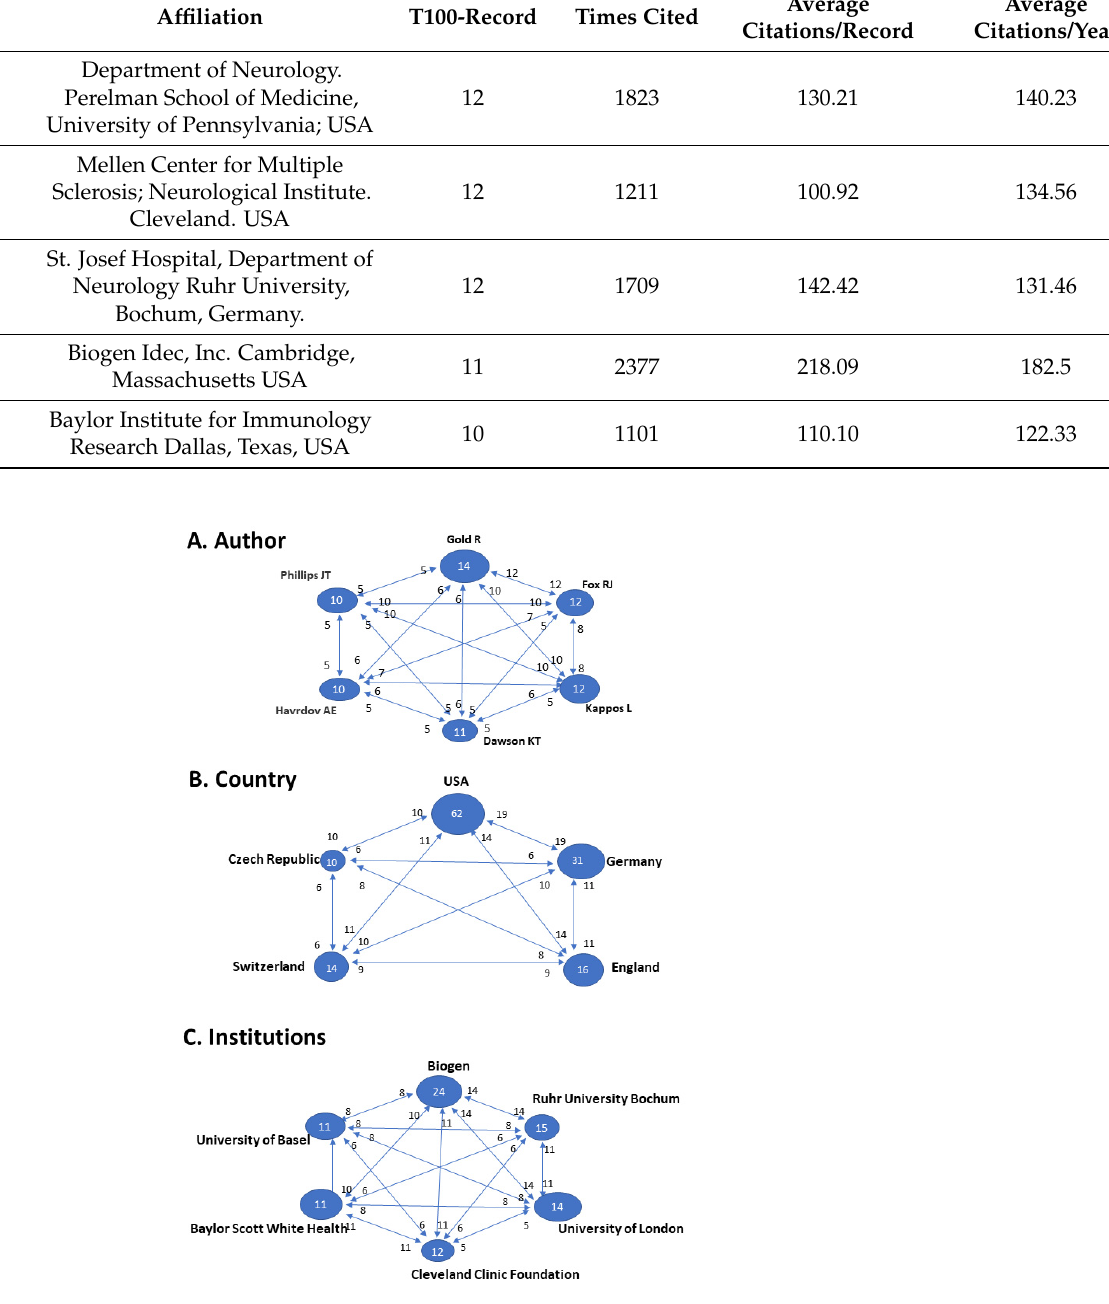
Figure 2. ( A ) The 6 prolific authors within the T100. Individual authors with over 5 publications on the dimethyl fumarate topic sorted by the number of articles published within the T100 list. ( B ) Geographical origin of the T100 Natalizumab publications. Individual country record of articles with more than 10 T100 items sorted by the number of publications Interaction between the above countries. ( C ) Relationship between the institutions with 11 or more publications on topic. Numbers inside the circles indicate the number of articles published. Connecting arrows and numbers affixed indicate number of papers together,